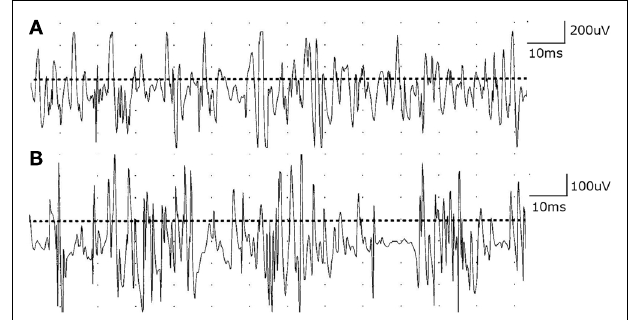
FIGURE 1 | (A) Motor unit potentials (MUPs) in deltoid muscle are normal in phases and slightly decreased in duration and amplitude with full recruitment. (B) Cervical paraspinal muscles show MUPs that are short duration and low amplitude with early